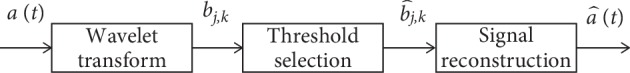
Basic principle block diagram of wavelet threshold denoising.